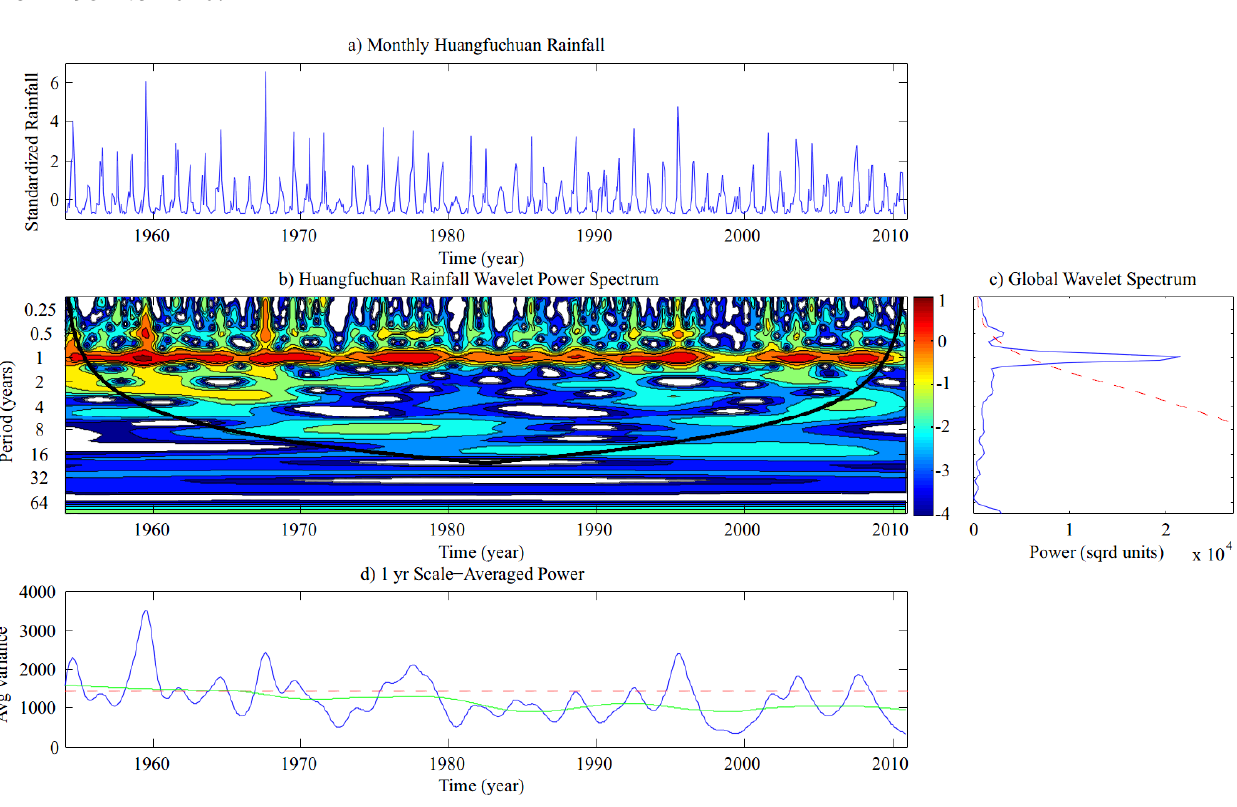
Figure 4. Wavelet analysis of monthly precipitation in the Huangfuchuan watershed; ( a ) is the standardized time series of precipitation; ( b ) is the wavelet power spectrum (WPS), the thick black arc delimits the cone of influence (COI) of the signal. High intensity is coded by the color red, whereas blue denotes the weaker intensity; ( c ) is the global wavelet spectrum for the WPS; and ( d ) is the averaged variance at the annual scale (blue). The dashed red line is the significant level. The green line shows the trend of the annual rainfall variance. Sqrd units indicates squared